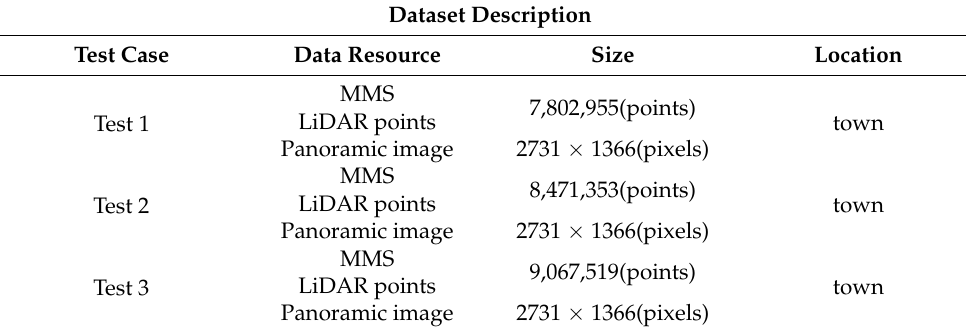
Table 1. Detailed description of the test